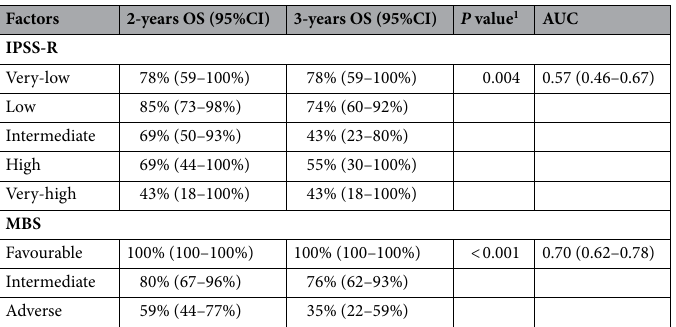
Table 4. Overall survival for IPSS-R and molecular based score (MBS). IC95% confidence interval of 95%; IPSS-R International Prognostic Score System-Revised. 1 Log-rank test.